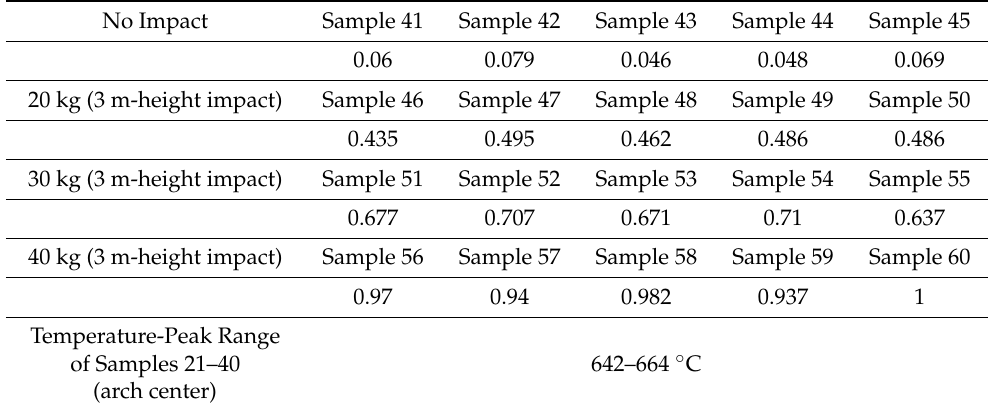
Table 8. The normalized shock-damage data of concrete samples after burning (center of the